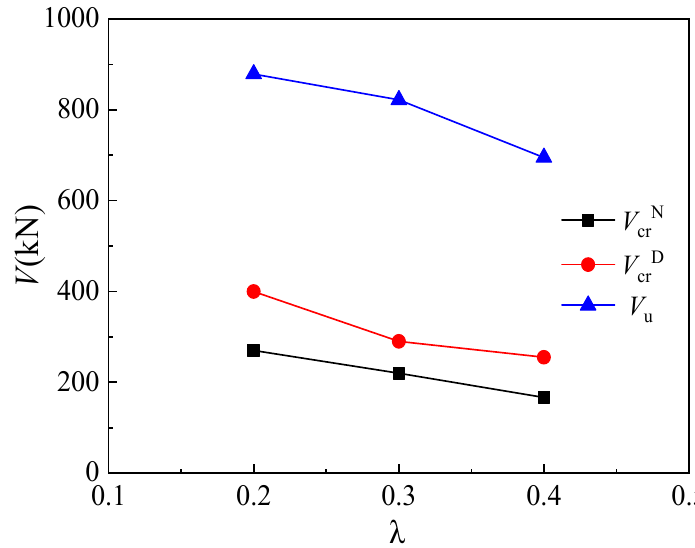
Figure 10. Relationship between load and shear span/depth ratio.